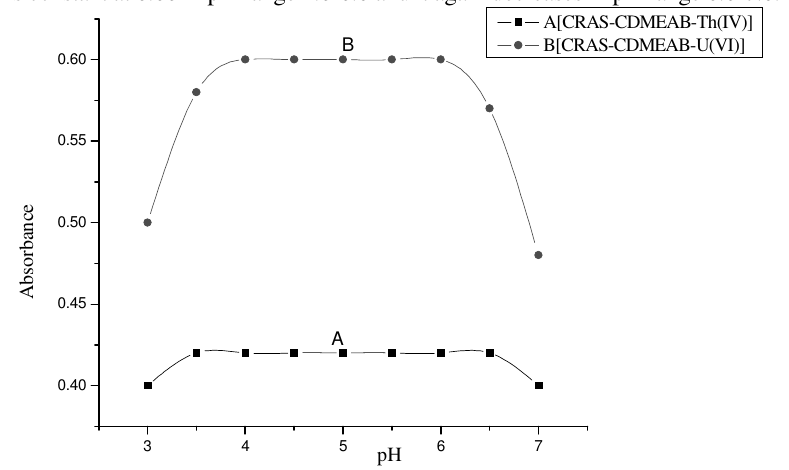
Figure 5. Variations in absorbance at the λ CRAS-CDMEAB-Th(IV); B) λ